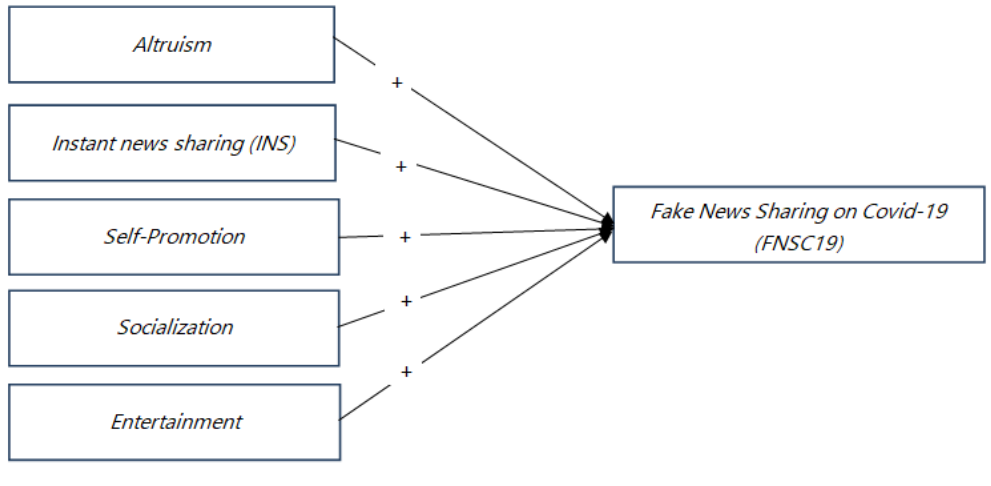
Figure 1: The Research Model (Source: Chadwick and Vaccari